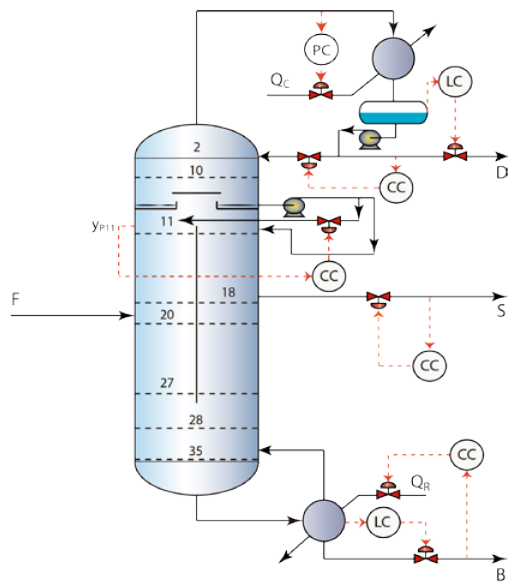
Figure 4. DB-LSV control structure of the